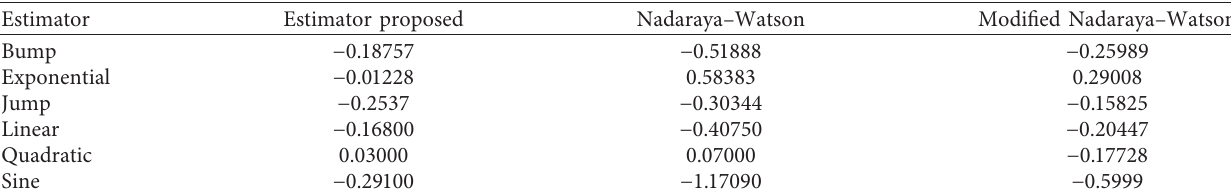
Table 2: Results of the bias.